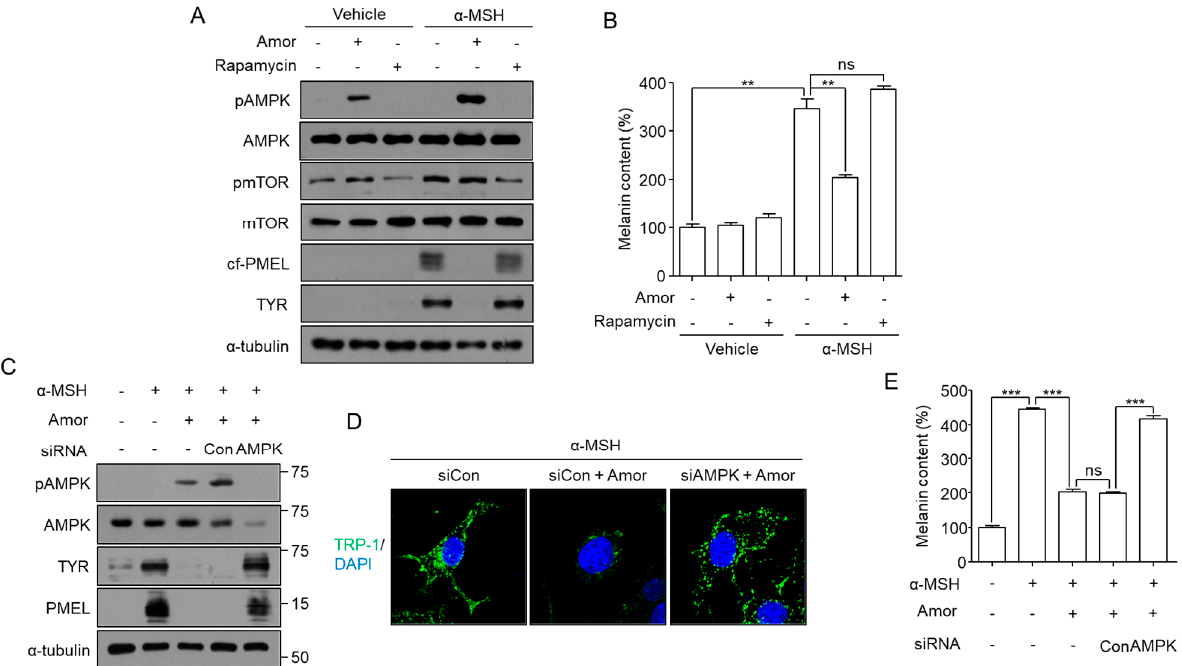
Figure 5. AMPK-dependent melanosome autophagy induced by amorphigenin. ( A , B ) B16F10 cells were treated with 0.012 ppm of amorphigenin (Amor) or 0.5 μ M of rapamycin in the presence or absence of 1 μ M of α -MSH for 48 h, and the indicated protein expression levels ( A ) and melanin content ( B ) were analyzed. To inhibit AMPK activity, validated AMPK siRNA, as described in the Materials and Methods section, was transfected into B16F10 cells, and then the cells were treated with amorphigenin for 48 h after α -MSH stimulation ( C – E ). To analyze melanosome degradation, TRP-1 spot formation was analyzed in the indicated experimental groups ( D ). Data were obtained from at least three independent experiments, and the values represent the mean ± SEM. Note: ns, not significant; *** p < 0.005 and ** p < 0.01 according to t -tests. Scale bar = 10 μ m.